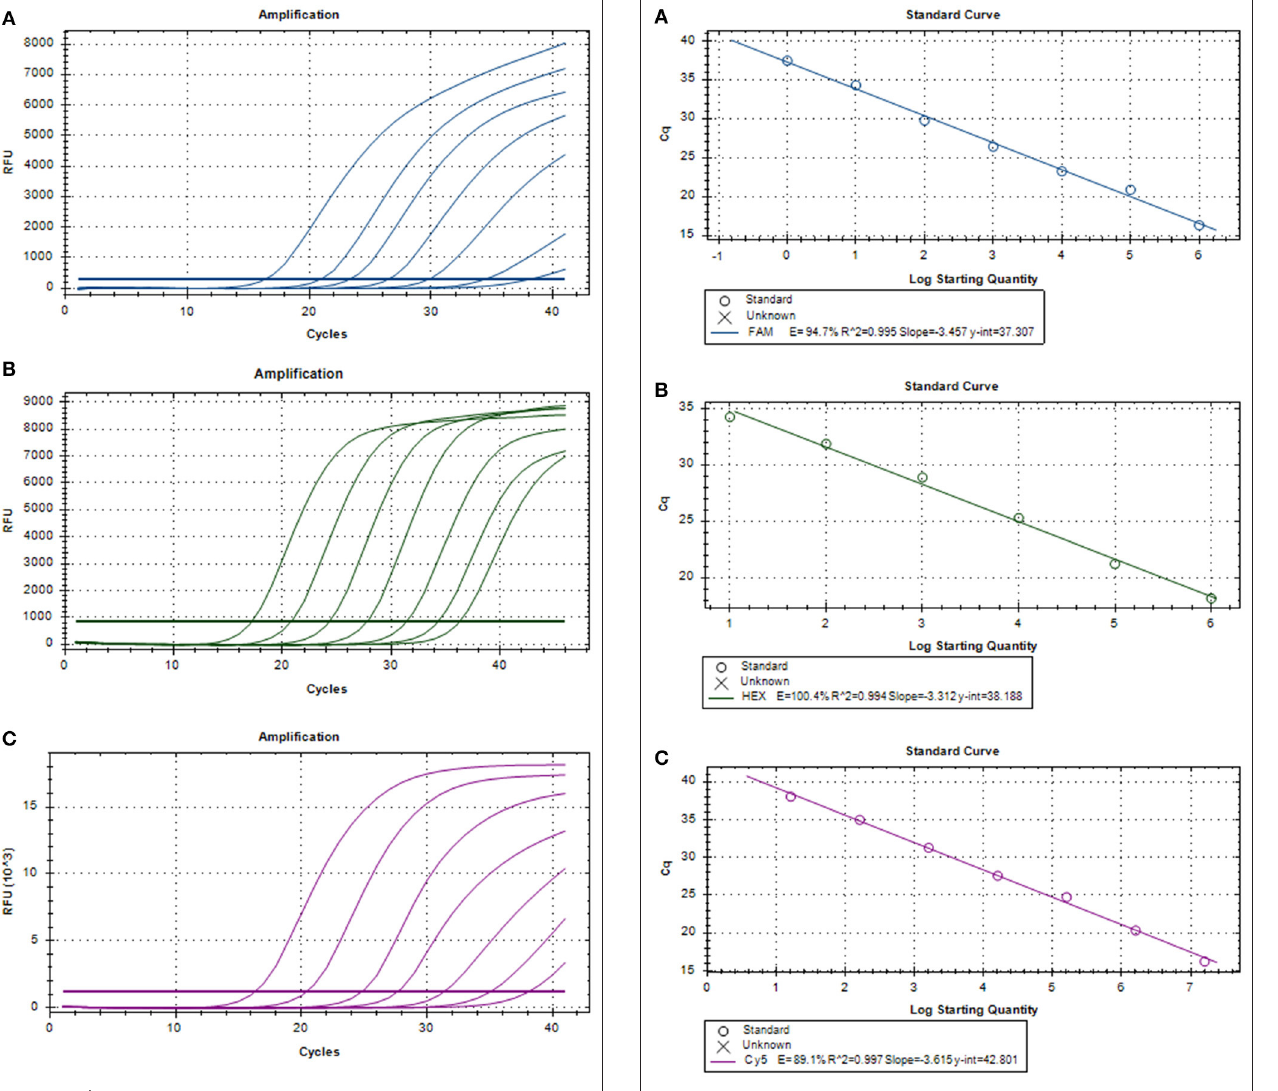
FIGURE 3 | (A) B646L standard curve (y = − 3.457x + 37.307; R 2 = 0.995). (B) EGFP standard curve (y = − 3.312x + 38.188; R 2 = 0.994). (C) mCherry standard curve (y = − 3.615x + 42.801; R 2 =